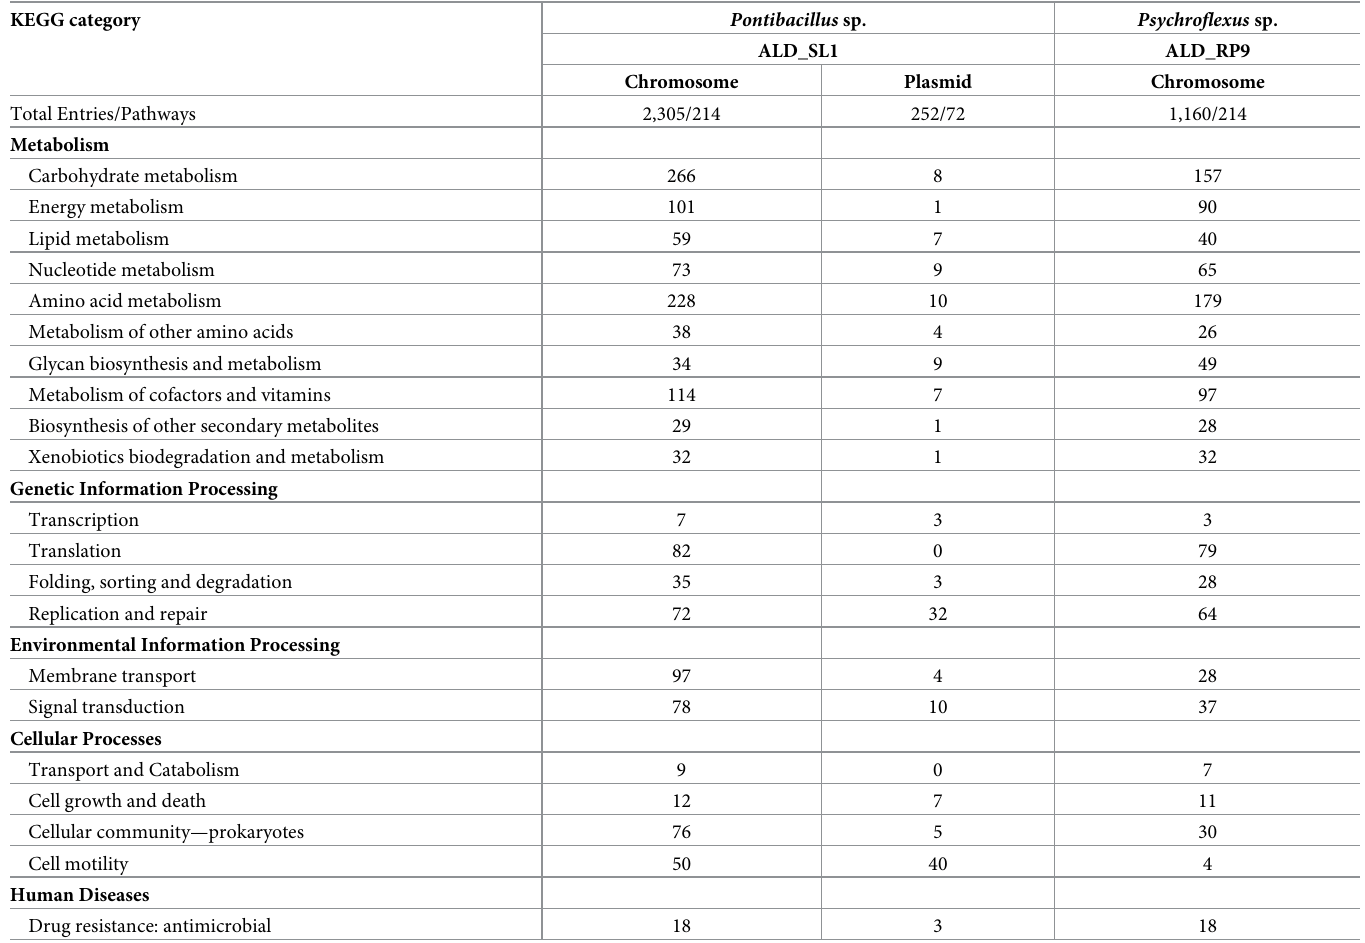
Table 3. Functional assignment of genes into KEGG